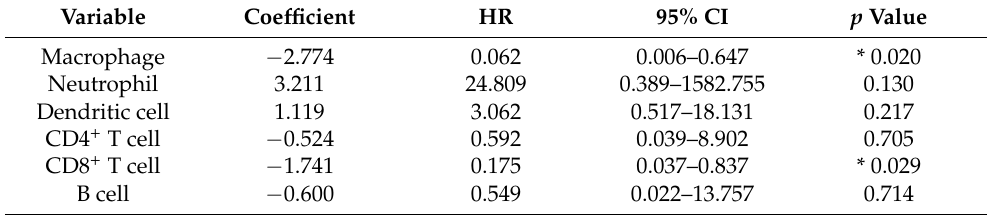
Table 2. Cox proportional hazard model showing hazard ratios for ccRCC conferred by